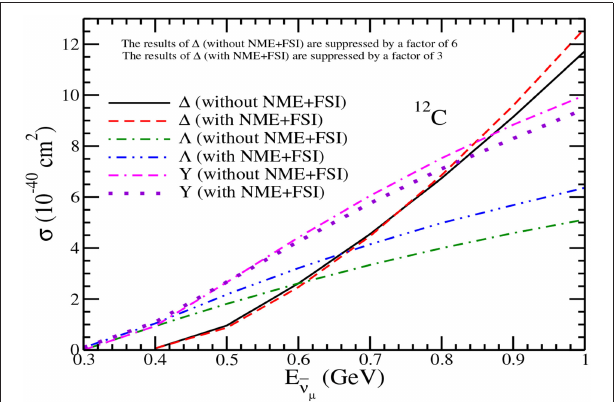
FIGURE 12 | Results for the charged current π − production in 12 C with and without NME+FSI. The results are presented for the pion production from the 1 , 3 , and total hyperon Y ( 3 6 ) with and without NME+FSI. Notice that = + the results of 1 without NME+FSI are suppressed by a factor of 6 and the results with NME+FSI are suppressed by a factor of 3 to bring them on the same scale.